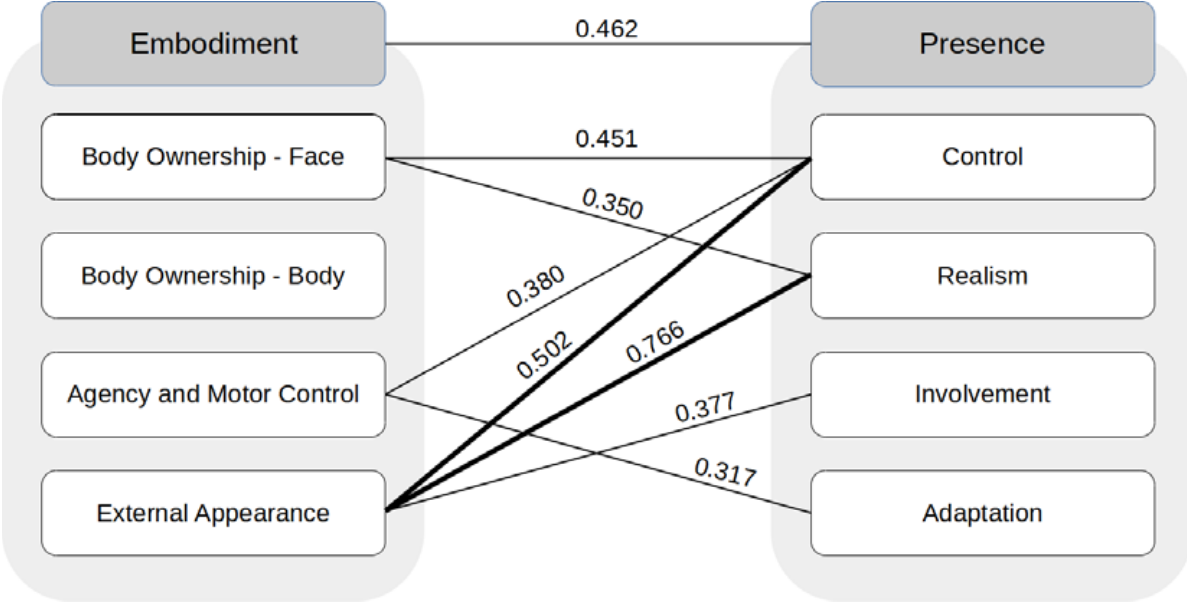
Figure 6. Moderate and significant correlations between embodiment and presence, including their subscales.